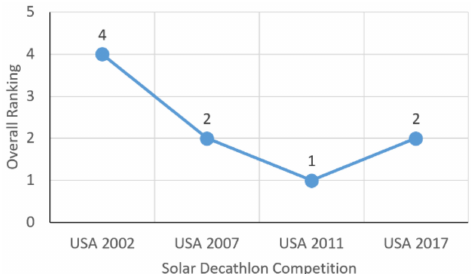
Figure 15. The overall ranking of the University of Maryland in four Solar